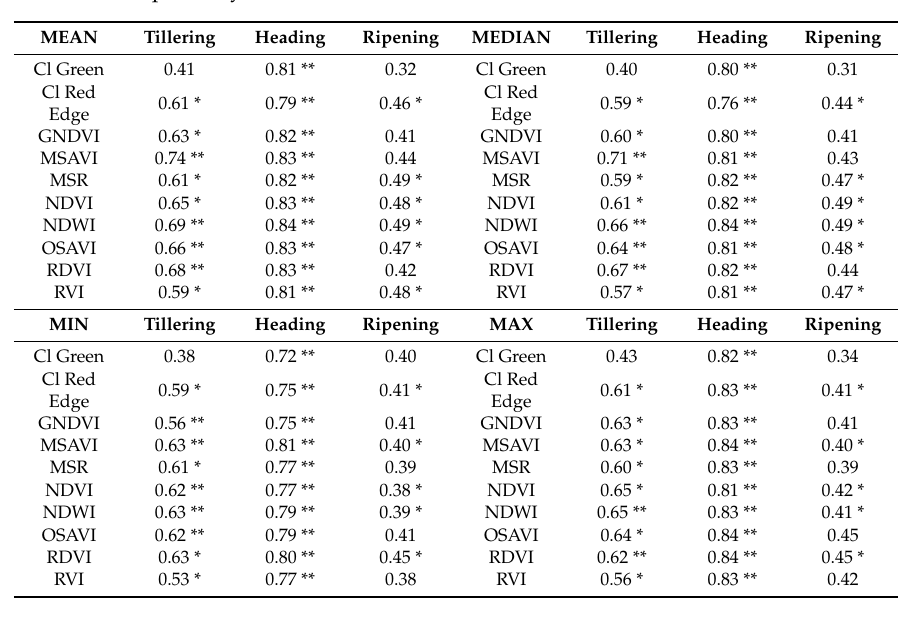
Heading Ripening MAX Tillering Heading Ripening Cl Green